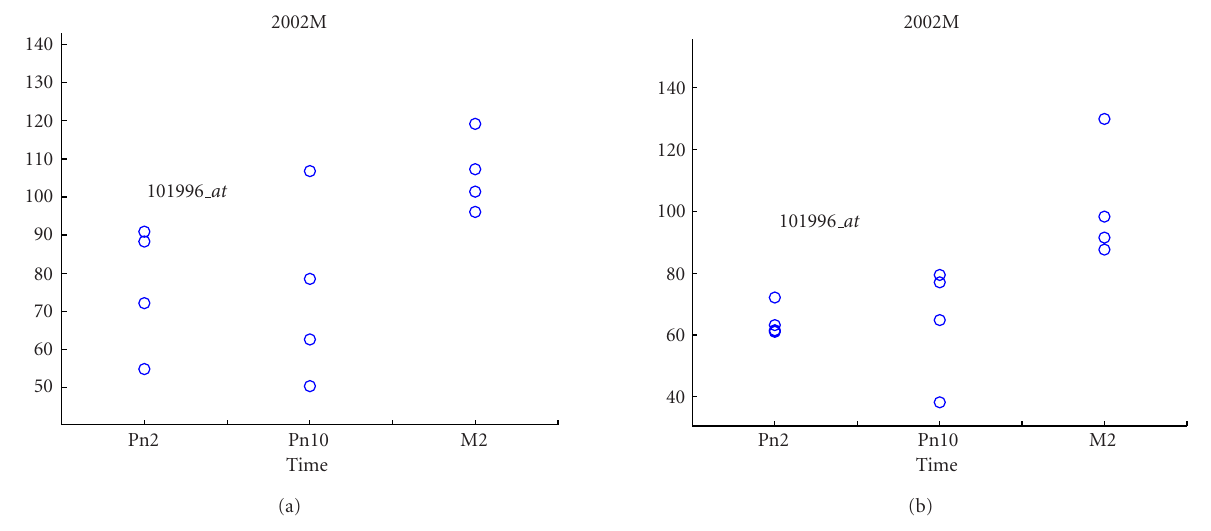
Figure 1: Responses for a particular gene (probe set number 101996 at ) in (a) knockout mouse versus (b) wild-type mouse for the di ff eren- tial expression study discussed in Section 4. There are three-time points (labeled Pn2, Pn10, and M2) and at each time point, there are four replicates. The y -axis denotes log base 2 hybridization level extracted by RMA from A ff ymetrix GeneChips.